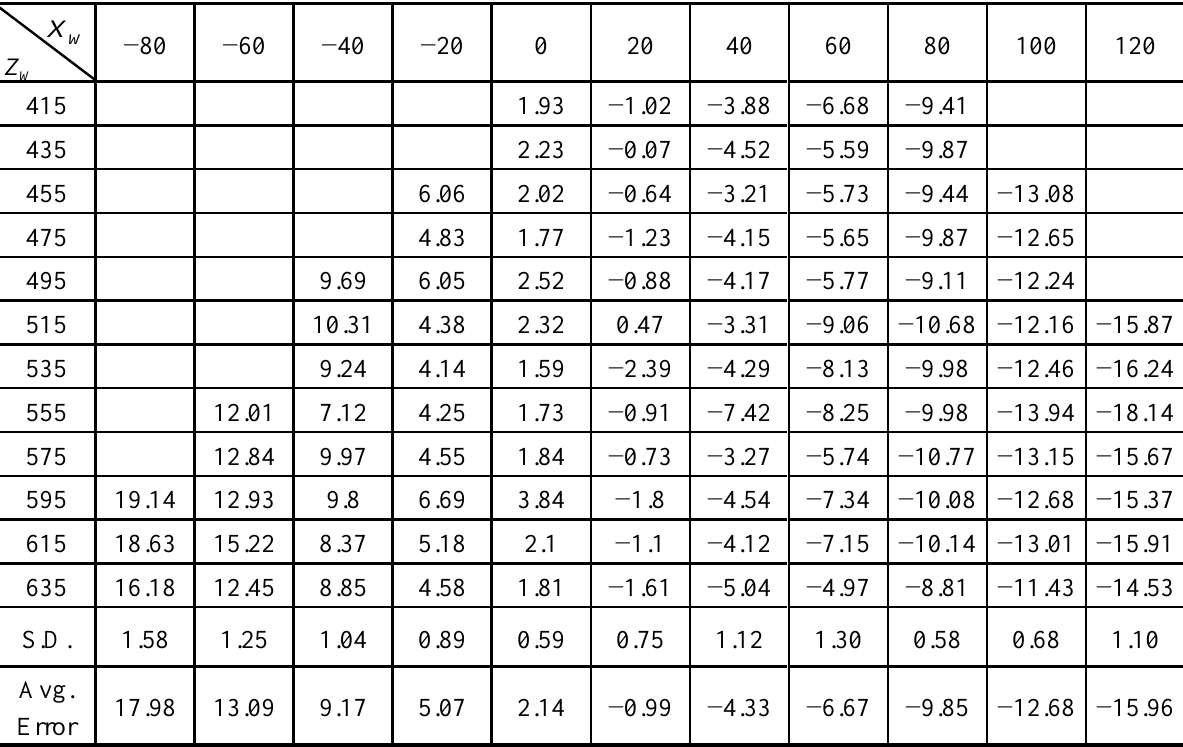
) measurement error at different X W